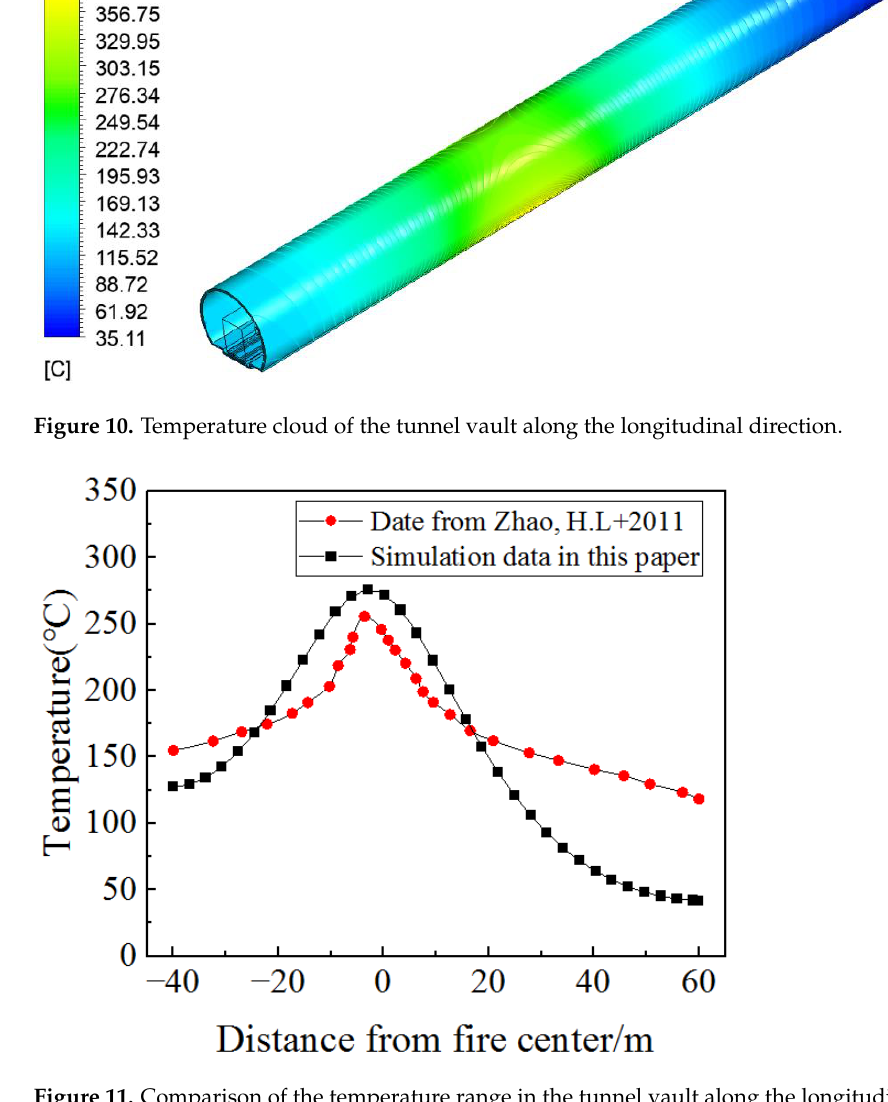
Figure 12. Overall temperature of the concrete track bed. In addition, the overall temperature field of the cast-in-place C35 concrete track bed was symmetrical with respect to the X axis (width) of the track bed, so half of it was taken for study in the following. The temperature distribution at different positions in the track bed are shown in Figure 13. There is little difference in the temperature along the depth of the cast-in-place C35 concrete track bed. The highest temperatures at the positions of surface, middle, and bottom were 475.73 °C, 474.79 °C, and 472.63 °C, respectively, and the lowest temperatures were 39.24 °C, 39.23 °C, and 39.22 °C, respectively. However, the temperature variations were obvious along the width and longitudinal direction.